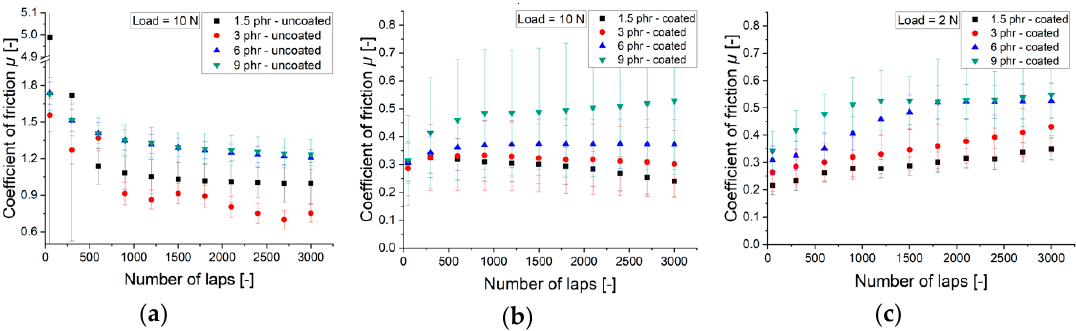
Figure 8. Coefficient of friction µ : ( a ) uncoated rubber samples with 10 N; ( b ) coated samples with a load of 10 N; ( c ) coated samples with a load of 2 N.